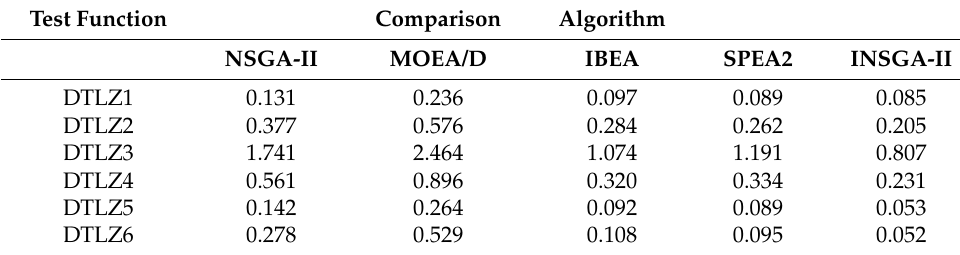
Table 5. IGD metric results for DTLZ